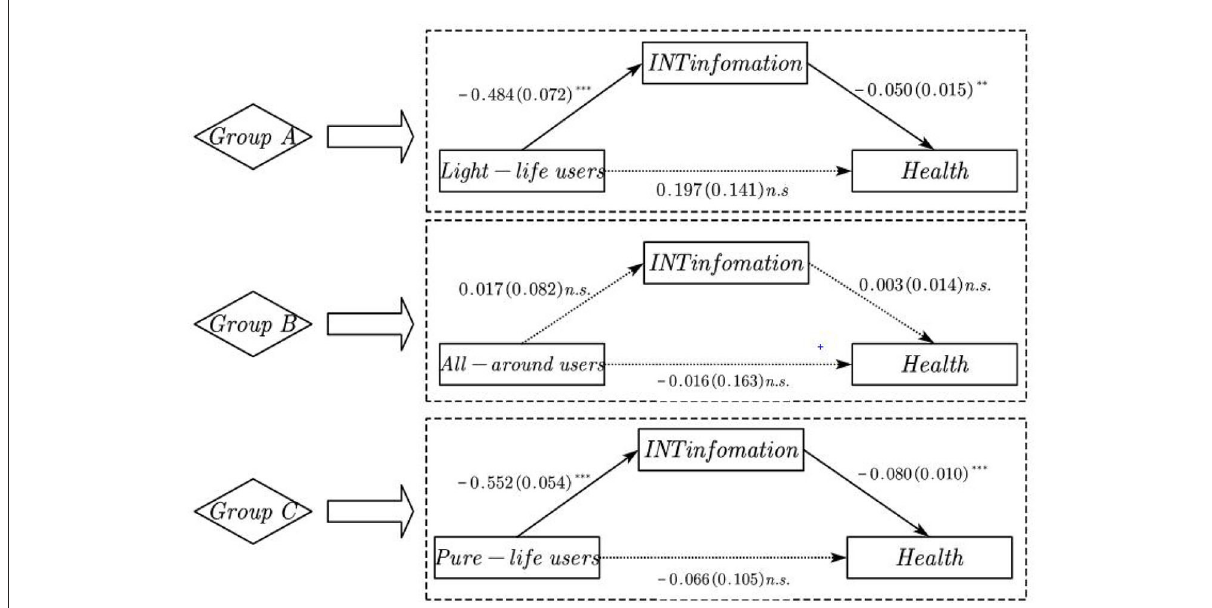
FIGURE2 Multigroup mediation model relative to the Functional users (C3). Note: (Group A) Comparison of Light-life users class (C1) against the Functional users class (C3). (Group B) Comparison of All-around users class (C2) against Functional users class (C3). (Group C) Comparison of Pure-life users class (C4) against Functional users class (C3). Significant directional paths are represented in solid lines and non-significant paths in dashed lines. Our statistical model included health at covariates (* P < 0.05. ** P < 0.01. *** P < 0.001).